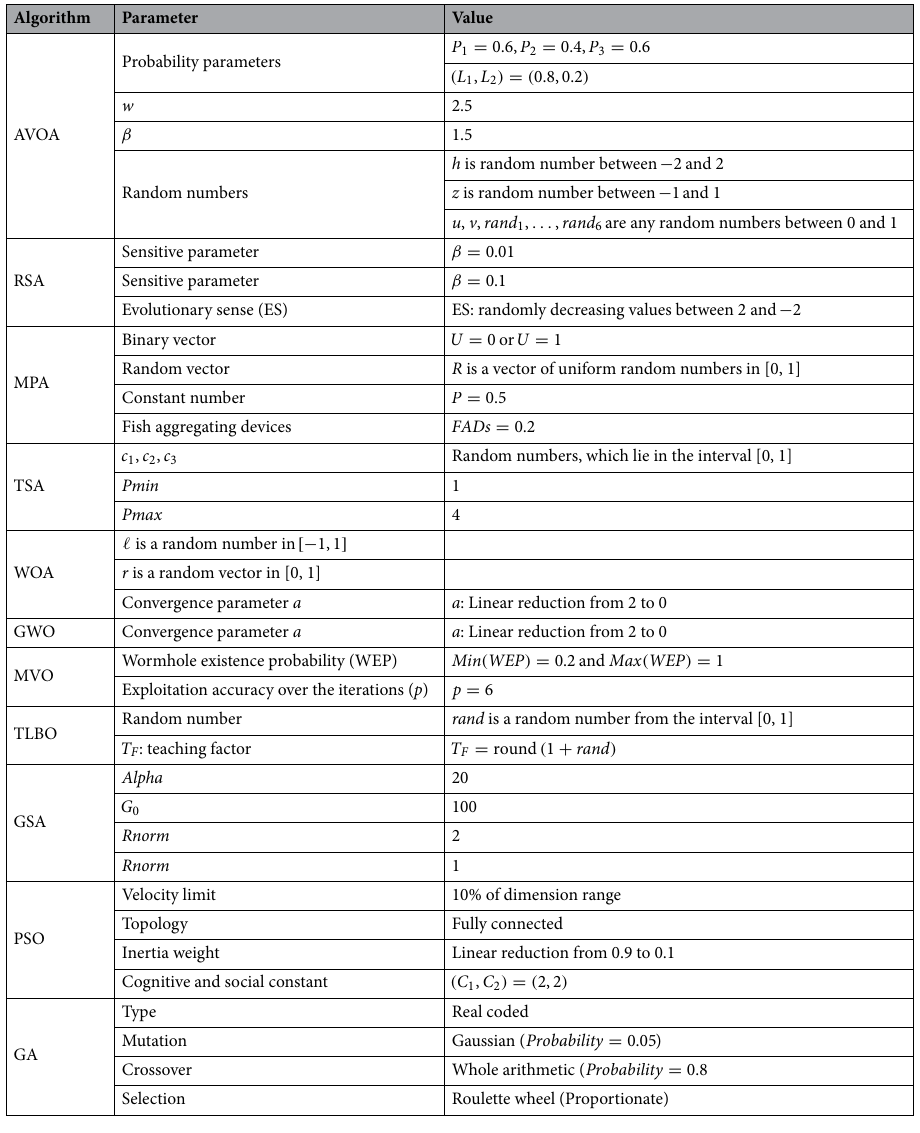
Table 1. Assigned values to the control parameters of competitor